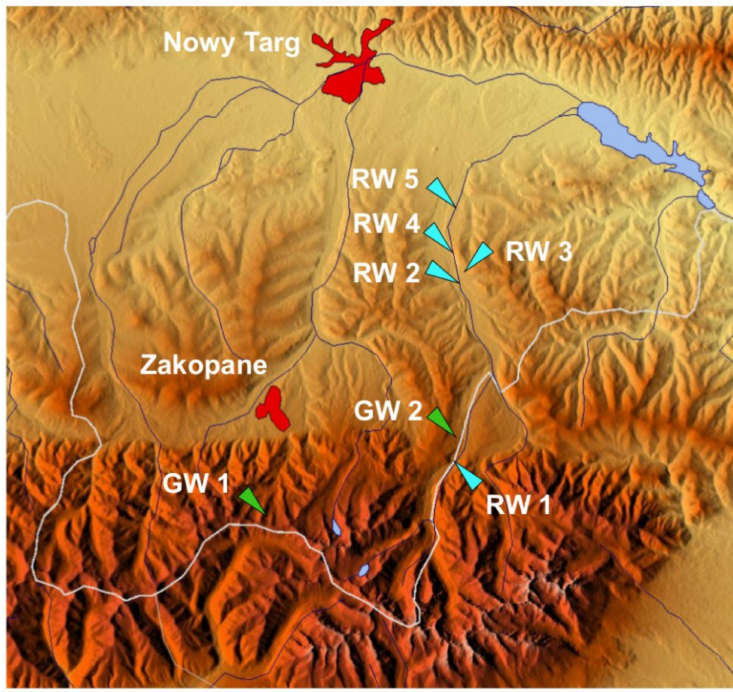
Figure 1. Study area and sampling